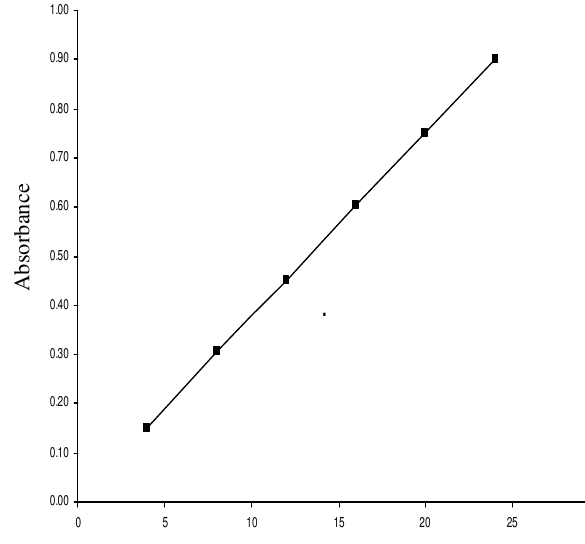
Figure 3. Beer’s law plot of BUCZ - SNP -